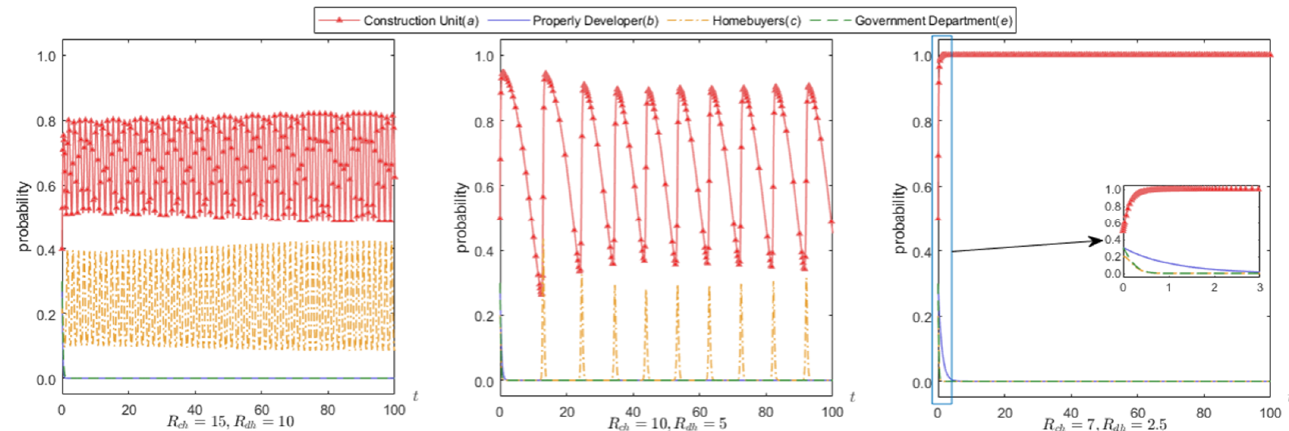
Figure 9. Impact of the cost of strict quality control by the construction unit and developers.